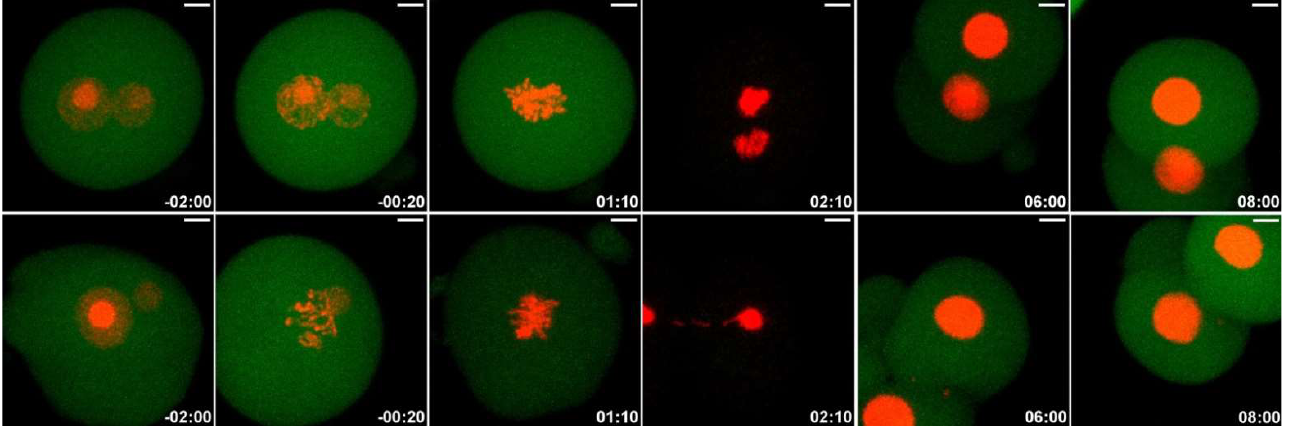
Figure 9. Still images from a time-lapse recording of the first mitosis in the control and NCS-treated one-cell embryo expressing securin-EGFP (green) and H2B-mCHERRY (red) mRNA. The Z-projections show the maximum intensity of the confocal sections. Scale bar = 10 µm. Additionally, see Movie S2 in the Supplementary Data.